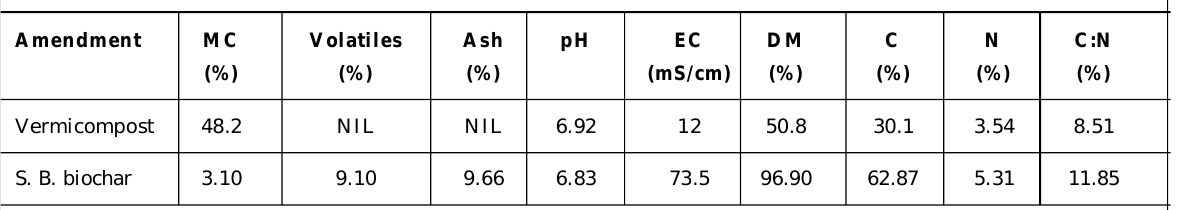
Table 1: Characteristics of vermicompost and